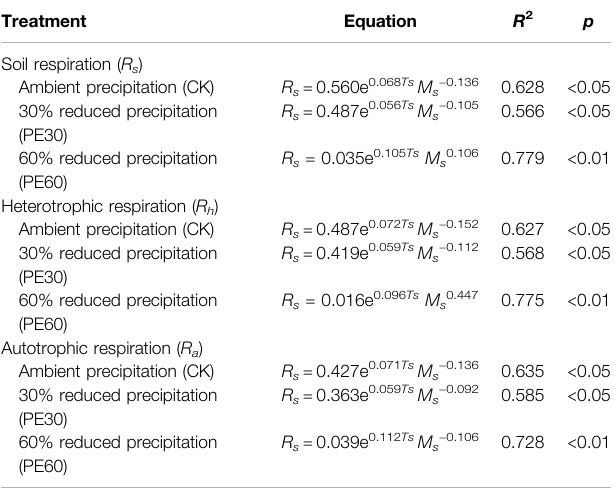
TABLE3| Combinedimpactsofsoiltemperature( T s , ° C)andsoilmoisture( M s ,%) on the variation of different soil respiration components ( R , μ mol m − 2 s − 1 ). R 2 and p values are reported.